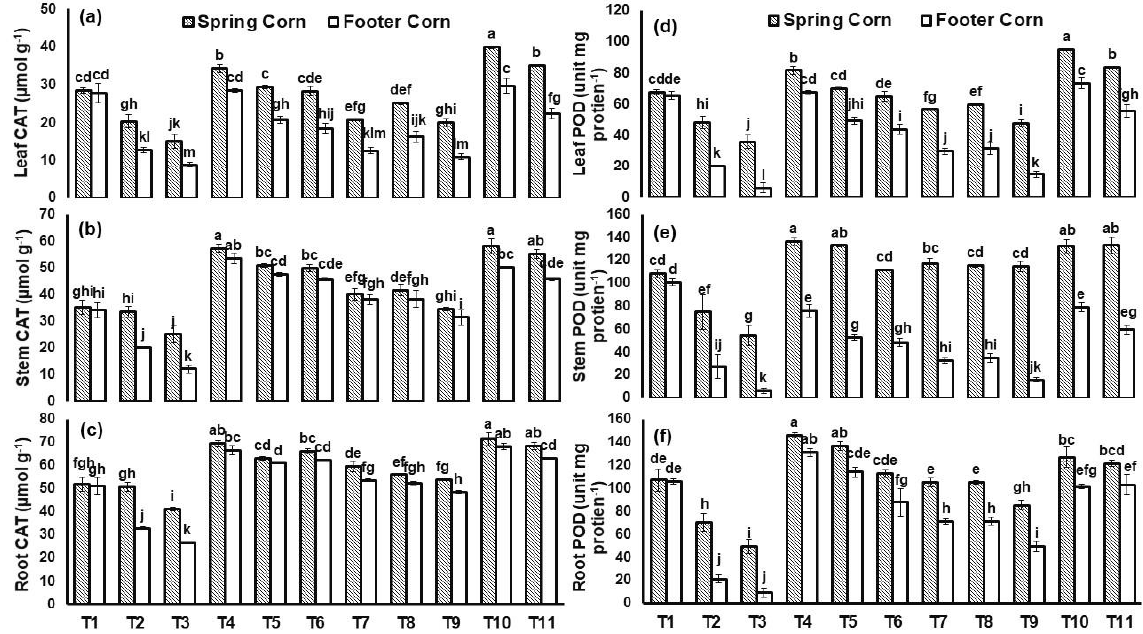
Figure 8. Catalase (CAT- (µmol g −1 ) in ( a ) leaf, ( b ) stem and ( c ) root and guaiacol peroxidase (POD- (unit mg protein −1 ) in ( d ) leaf, ( e ) stem and ( f ) root of Zea mays L. plant grown in heavy-metal-con- taminated soil under different treatments such as T1 = Control; T2 = Cu (300 ppm); T3 = Ni (100 ppm); T4 = F2; T5 = BC (2%); T6 = F2 + Cu (300 ppm); T7= F2 + Ni (100 ppm); T8 = BC (2%) + Cu (300 ppm); T9 = BC (2%) + Ni (100 ppm); T10 = F2 + BC (2%) + Cu (300 ppm) and T11= F2 + BC (2%) + Ni (100 ppm). Values are the average of three replicates ± standard error (SE). Mean bars sharing similar lower-case alphabetic letters were non-significant ( p < 0.05) to each other while different letters rep- resented significant difference declared by one-way ANOVA using LSD test at p ≤ 0.05. Similarly, there was significant ( p ≤ 0 .05) genotypic variation in CAT and POD activ- ity shown by both cultivars against applied stresses (Figure 8). Leaf CAT (67%) and POD (90%) conc. was significantly reduced under Ni toxicity relative to control in spring corn. However, T. asperellum and BC combined application enhanced the CAT and POD con- centration under Cu toxicity irrespective of the cultivars. The maximum increase in leaf CAT (96%) and POD (98%) was reported in spring corn with treatment (BC + T. asperellum + Cu) relative to Cu stress (Figure 8). 2.3. Principal Component Analysis (PCA) Physiological and biochemical parameters of both maize cultivars and soil were sta- tistically analysed to evaluate the most efficient treatments used in the study by construct- ing biplots of PCA (Figure 9). PCAs contributed to 82.13% of the variance in plant and 89.48% of the variance in soil biplots (Figure 9). The results of both biplots suggested that different parameters of growth, secondary metabolites and antioxidant enzyme activity showed a highly negative correlation with applied Cu and Ni stresses, whereas HM (Cu and Ni) toxicity were highly positively correlated with concentration of ROS and accumu- lation of Cu and Ni in different parts of plant and in soil. In the biplot of a plant, secondary metabolites showed a highly positive relationship with antioxidant enzyme (APX, CAT, SOD and POD) activity but a highly negative relationship with ROS (H 2 O 2 and MDA) concentrations of both maize cultivars.